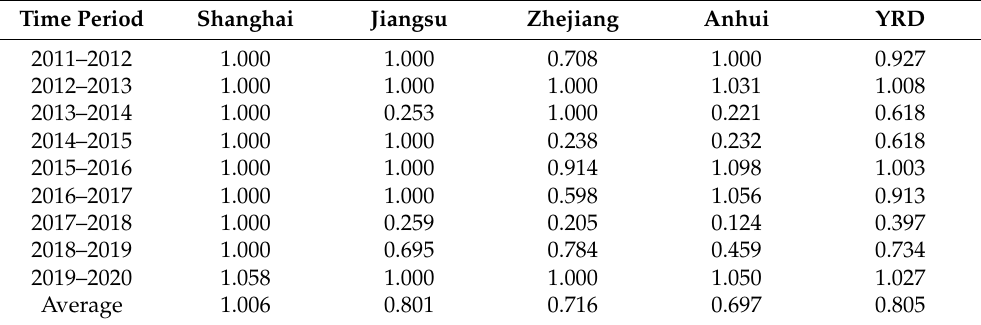
Table 8. Distribution of Result Transformation Efficiency in high-tech Manufacturing Industry